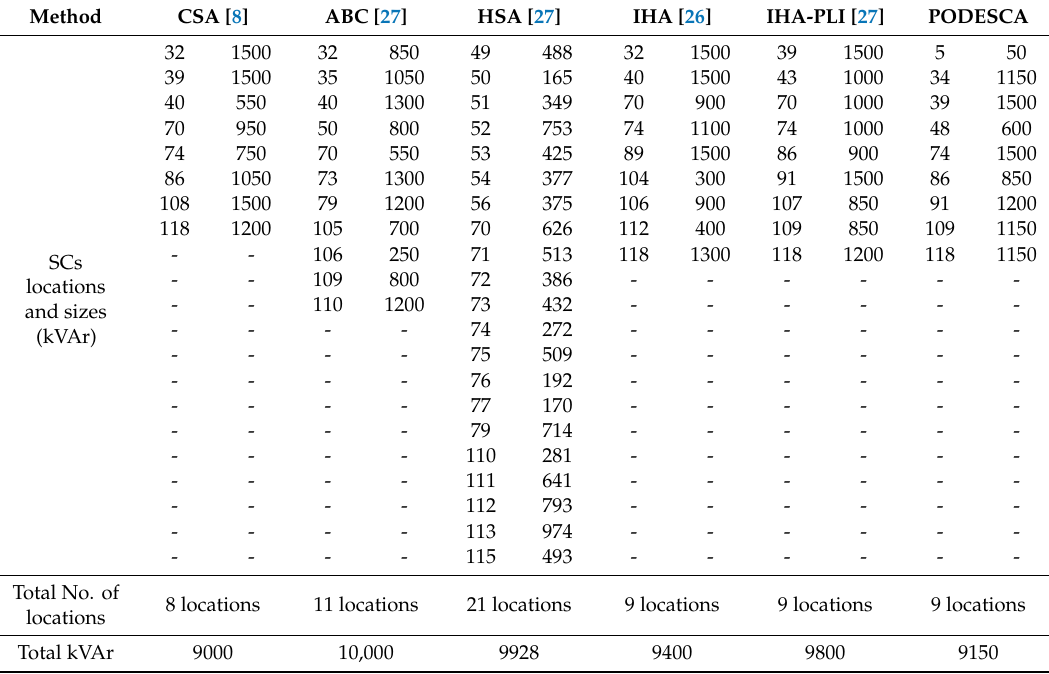
Table 11. Optimal locations and sizes of SCs by PODESCA comparing to other methods for the 118-bus system.